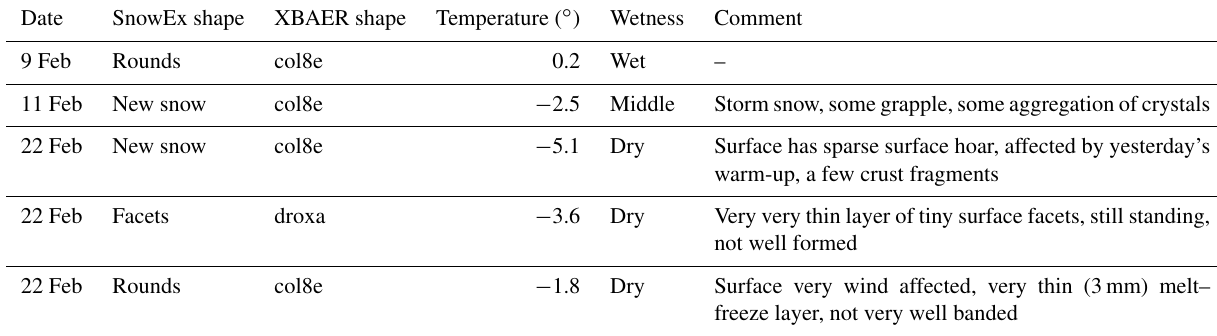
Table 5. The comparison between SnowEx snow grain shape and XBAER-retrieved SGP during February 2017.